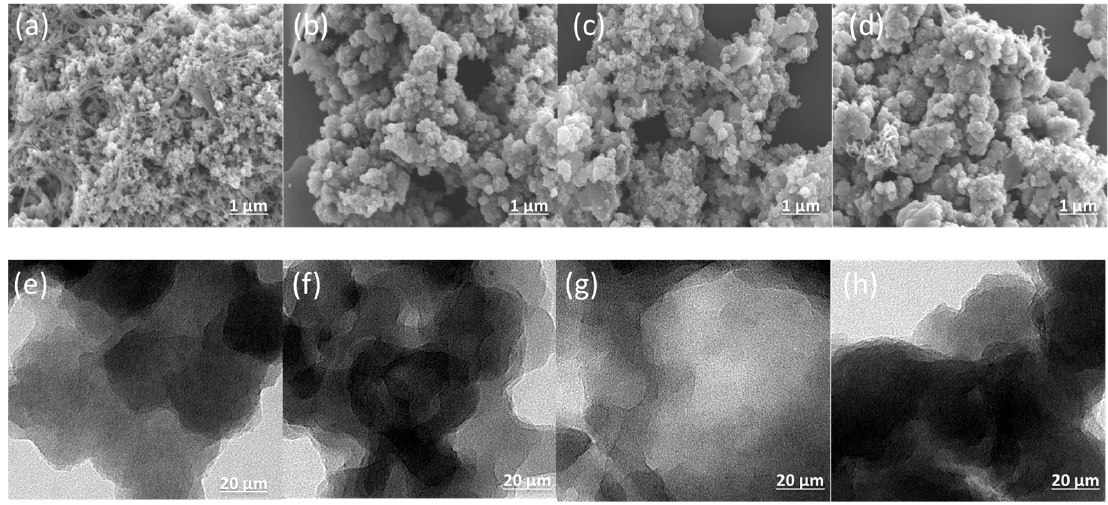
Figure 5. SEM and TEM images of An-CTF-10-400 ( a , e ), An-CTF-20-400 ( b , f ), An-CTF-10-500 ( c , g ), and An-CTF-20-500 ( d , h ).